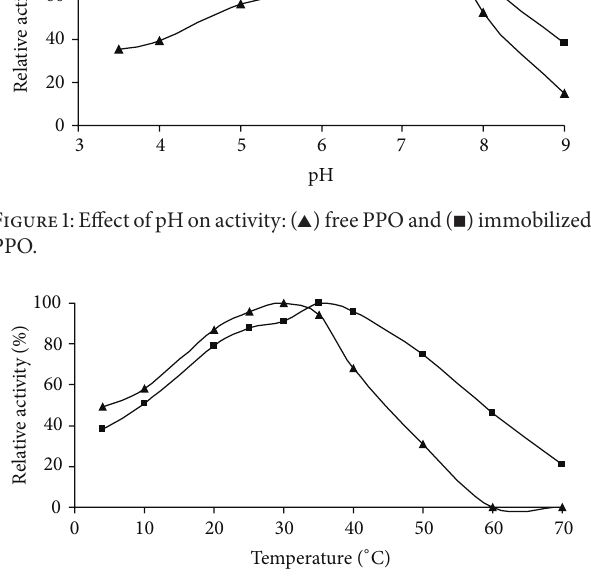
Figure 2: Effect of temperature on activity: ( 󳵳 ) free PPO and ( ◼ ) immobilized PPO.